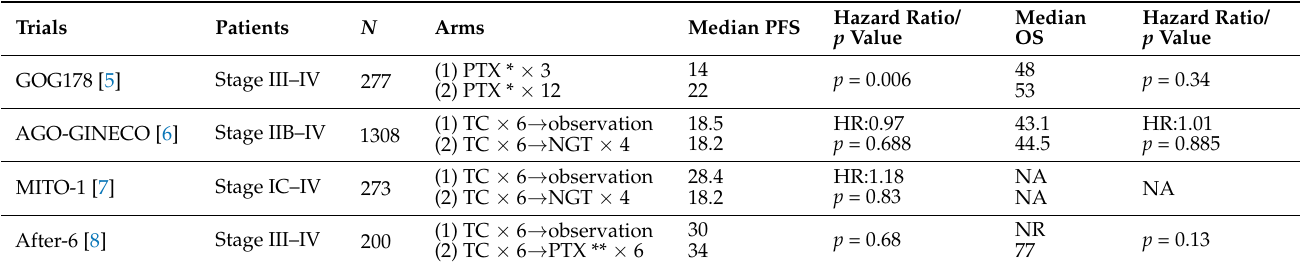
Table 1. Previous trials of first maintenance therapy using cytotoxic